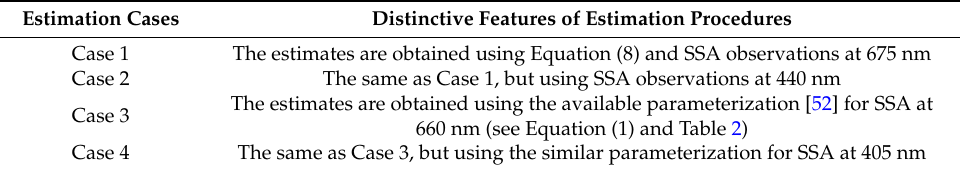
Table 3. Distinctive features of the different cases of estimation of the EC/OC ratio using the AERONET